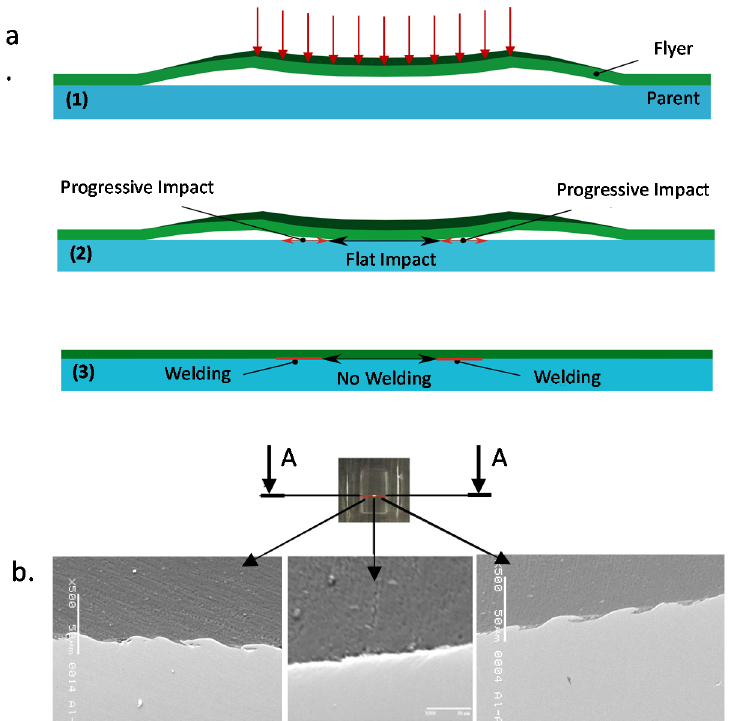
Figure 7. ( a ) Schematic of weld formation by progressive deformation of the hump from the center to the sides illustrated in three steps (1 to 3) [47]; ( b ) The orientation of the weld waves is in opposite directions away from the unwelded center [46].